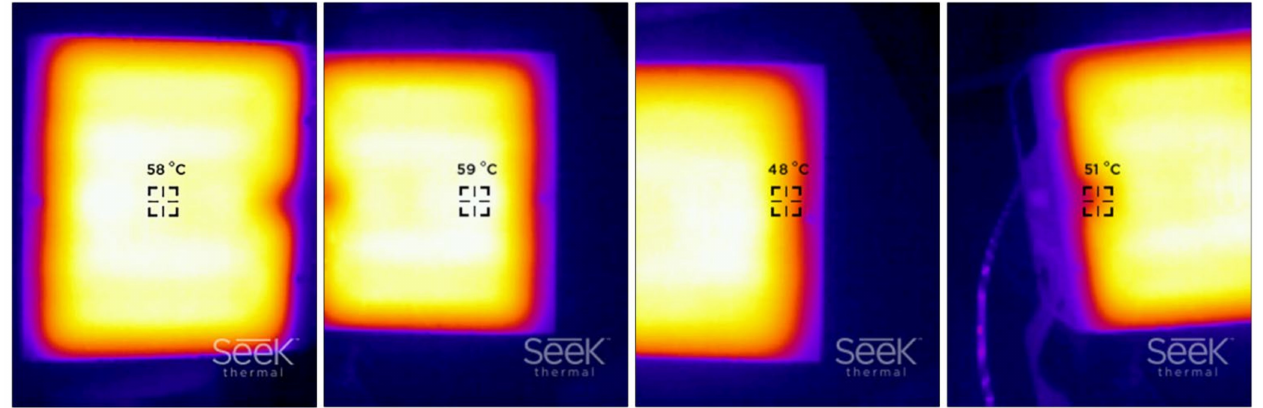
Figure 10. Heat maps of print